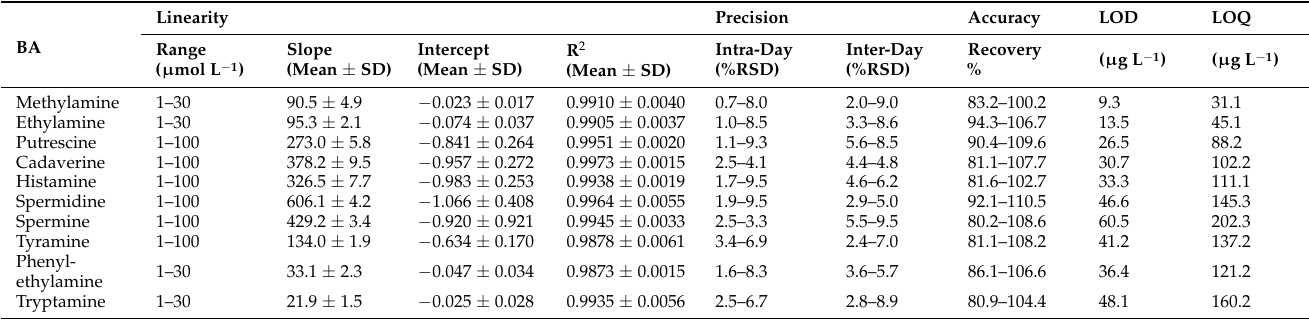
Table 2. Linearity, recovery range of BAs for three concentration levels (%), relative standard deviation (%RSD), the limit of detection (LOD), and limit of quantification